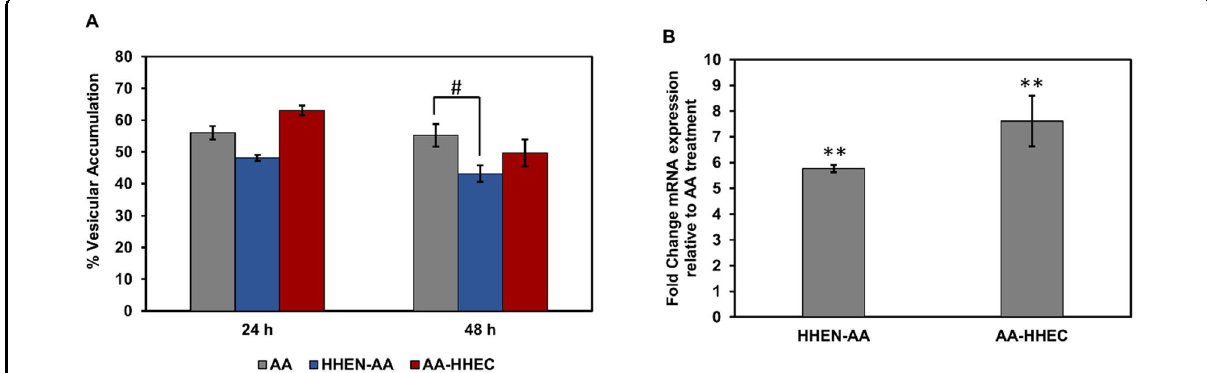
Fig. 7 Poly-histidine-tagged ferritin protein nanocages. A Percent Fe accumulation in the endosomal/lysosomal vesicular compartments in cells incubated with 75 nM AA, HHEN-AA and AA-HHEC for 24 and 48 h. The percentages were calculated relative to the total amount of Fe measured in the endosomal/lysosomal, cytoplasmic and membrane compartments. B mRNA expression levels of L-ferritin in macrophages in the presence of 75 nM HHEN-AA and AA-HHEC for 48 h. The mRNA expression levels were calculated relative to those in cells treated with AfFtnAA ( n = 3) ( # p < 0.1, ** p <